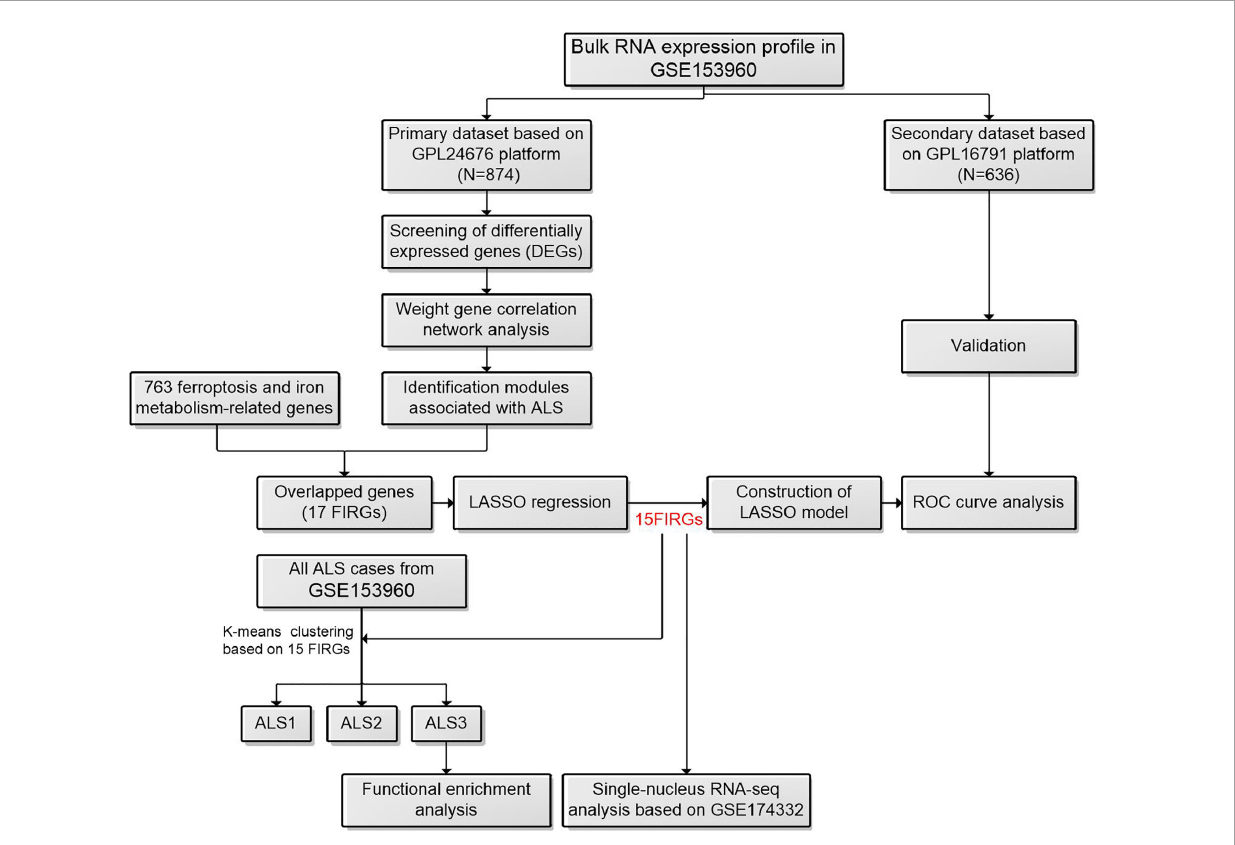
FIGURE1 The workflow of this study. ALS, amyotrophic lateral sclerosis; FIRGs, ferroptosis and iron metabolism-related genes; LASSO, least absolute shrinkage and selection operator; ROC, receiver operating